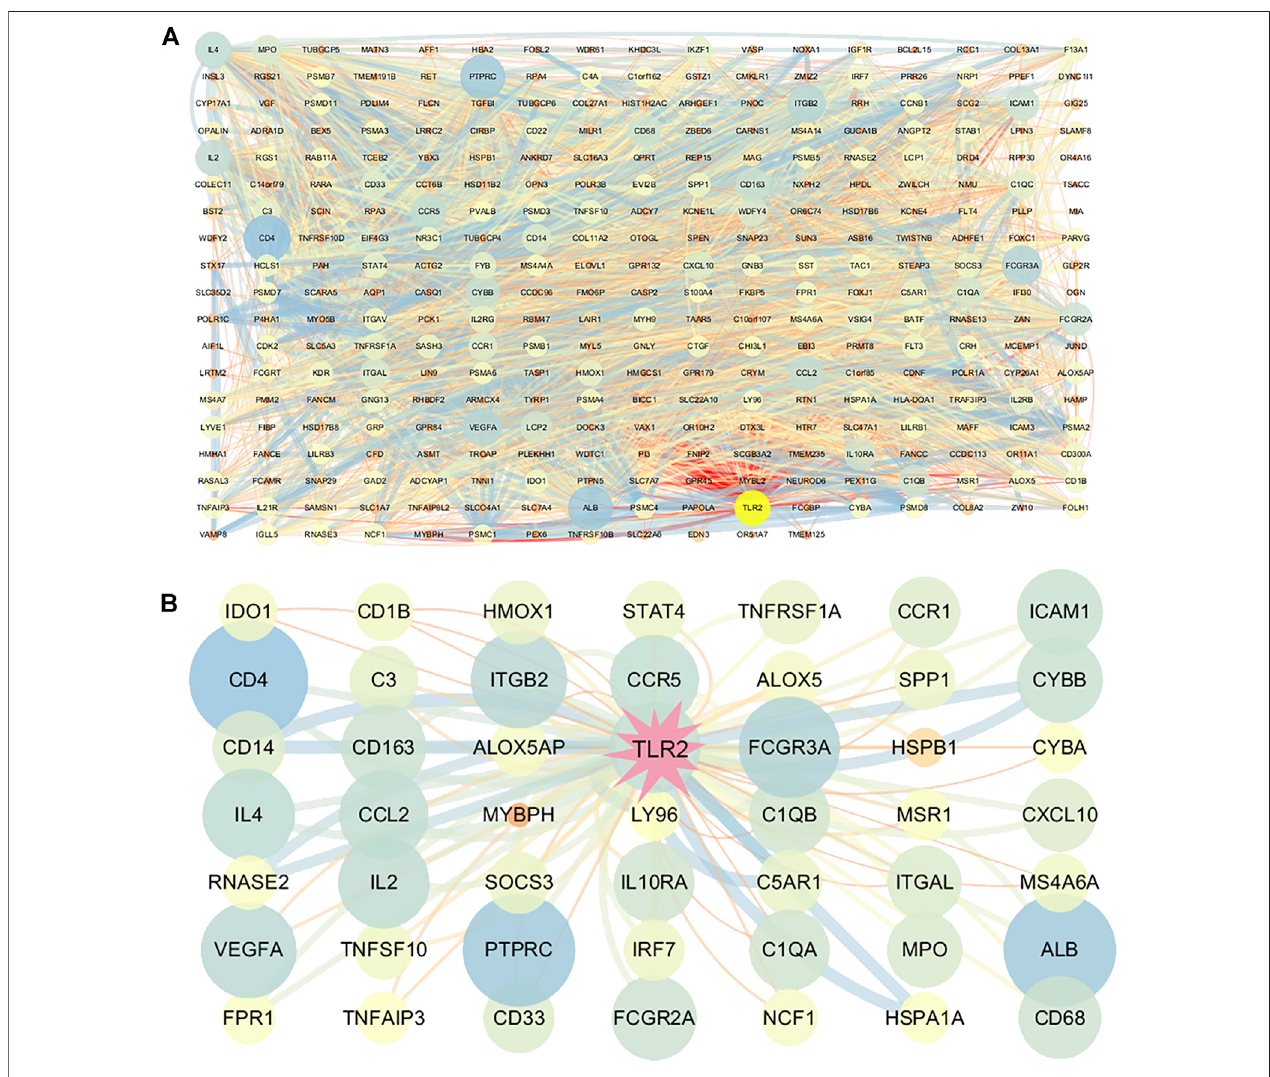
FIGURE 6 | Construction ofthe protein – protein interaction (PPI) network consisting of DEGs. (A) PPI of DEGs. (B) Partial network centered on TLR2. The size and colorofthenodesre fl ectthedegreeandthewidthand coloroftheedgesre fl ectthecombined scores(color:frombluetored).Larger sizeandbluernodes indicatedthe higher degree while wider and bluer lines indicated the higher combined